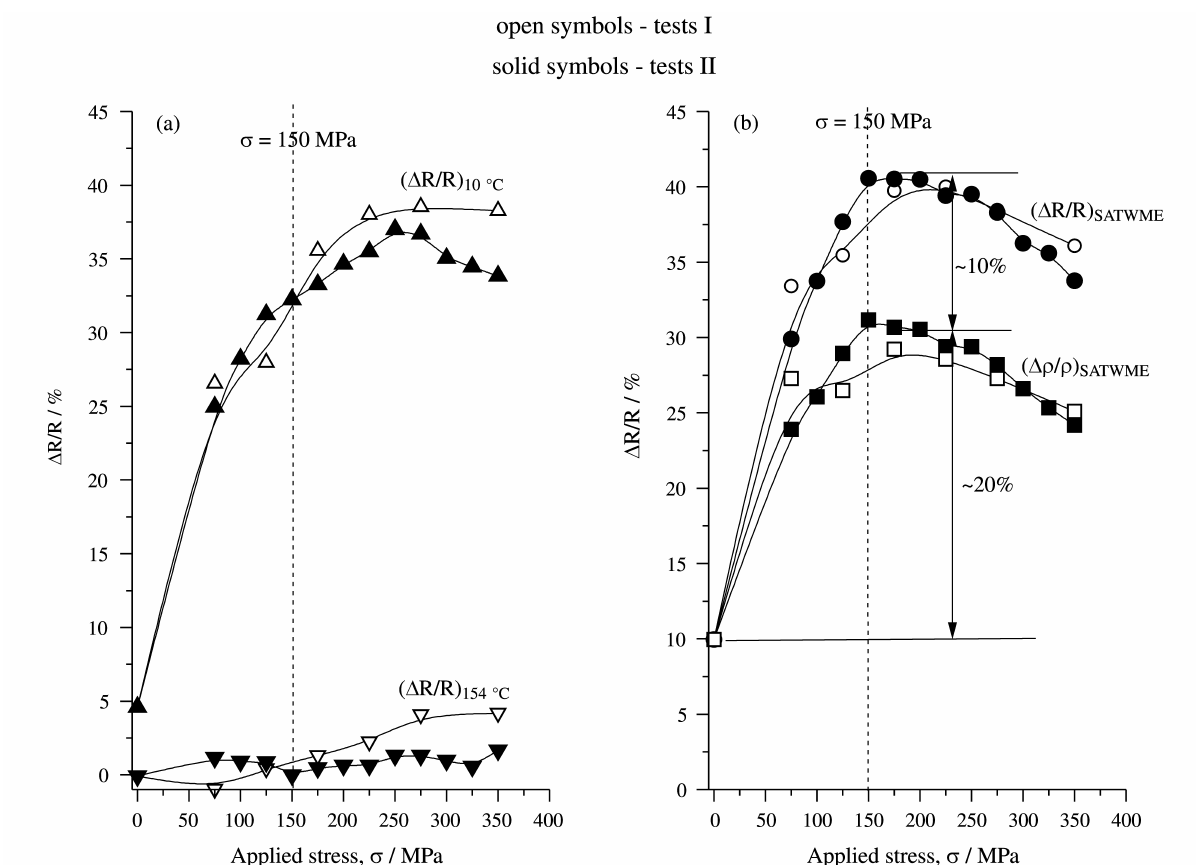
Figure 5. Normalized variation of ER associated to the strains shown in Fig. 4: (a) ( ∆ R/R) 10°C and ( ∆ R/R) 154°C associated to ( ε M ) 10°C and ( ε P ) 154°C ; (b) ( ∆ R/R) SATWME and ( ∆ρ / ρ ) SATWME associated to